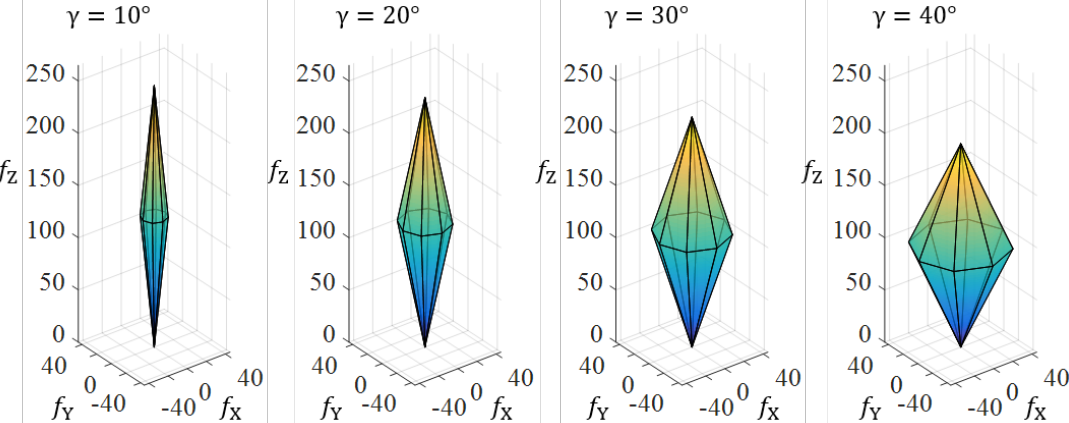
Figure 9. Propulsion forces margins for PTX8 configuration consisting of EPUs setup 5.